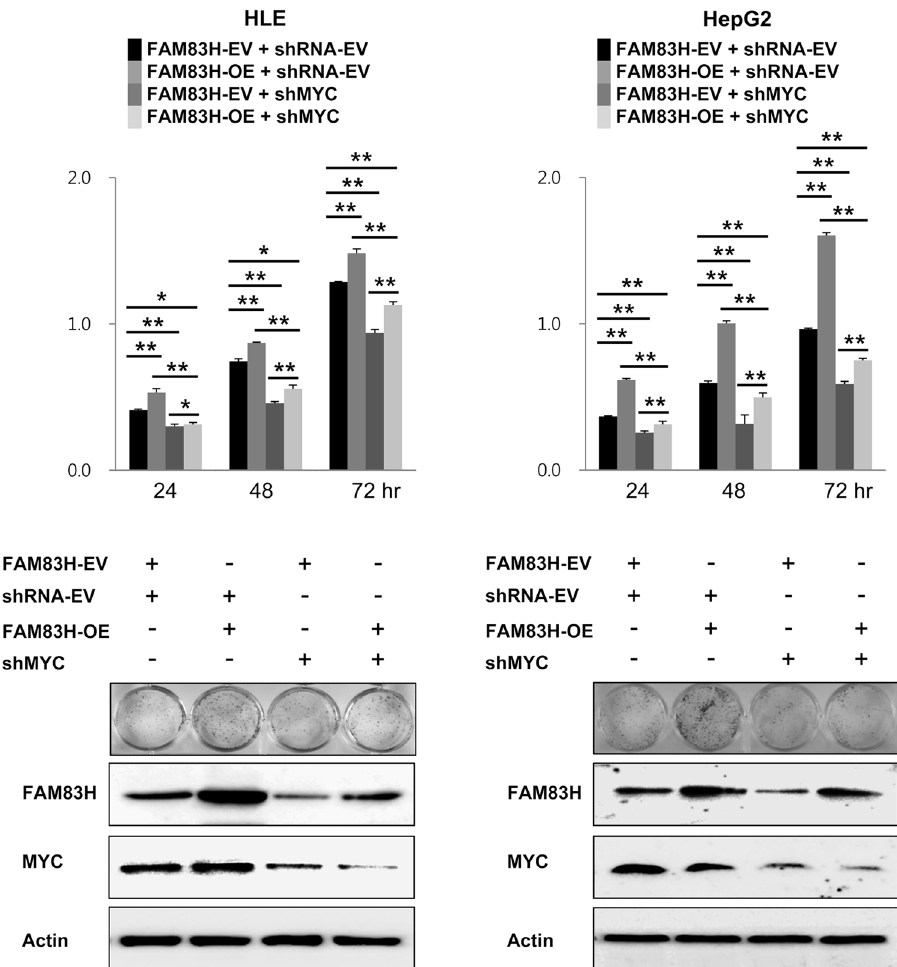
Figure 4. Overexpression of FAM83H increased proliferation of hepatocellular carcinoma cells with a condition of both basal expression of MYC and knock-down of MYC. Overexpression of FAM83H increased proliferation of both HLE and HepG2 cells and knock-down of MYC by shRNA for MYC decreased proliferation of both HLE and HepG2 cells as indicated by MTT and colony-forming assays. The proliferation activity of the cells co-transfected FAM83H overexpression vector and shRNA for MYC was significantly higher compared with the cells with a MYC knock-down, but still lower than cells transfected with a control vector, which have a basal expression level of MYC. OE, overexpression; the p values were calculated by one-way ANOVA with Tukey’s HSAD test; * p < 0.05; ** p <